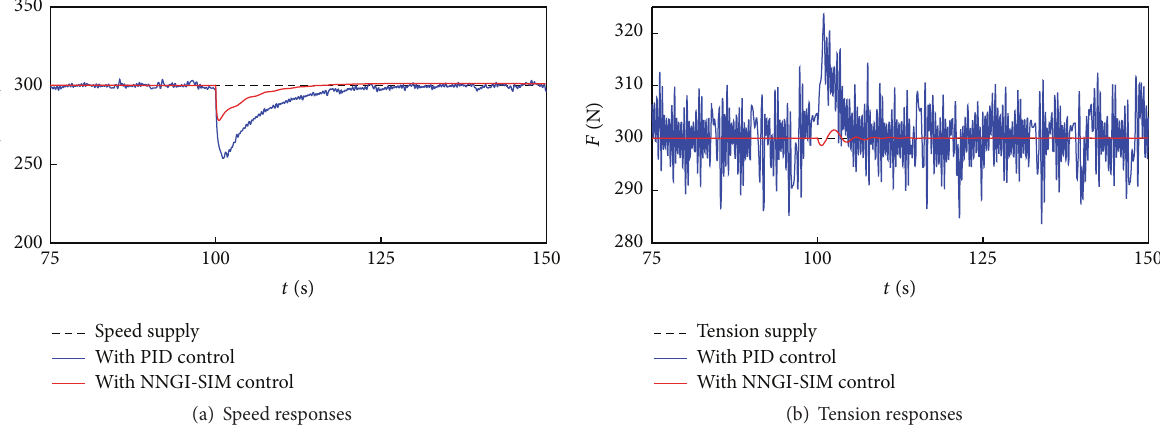
Figure 8: Simulated responses for sudden increased load